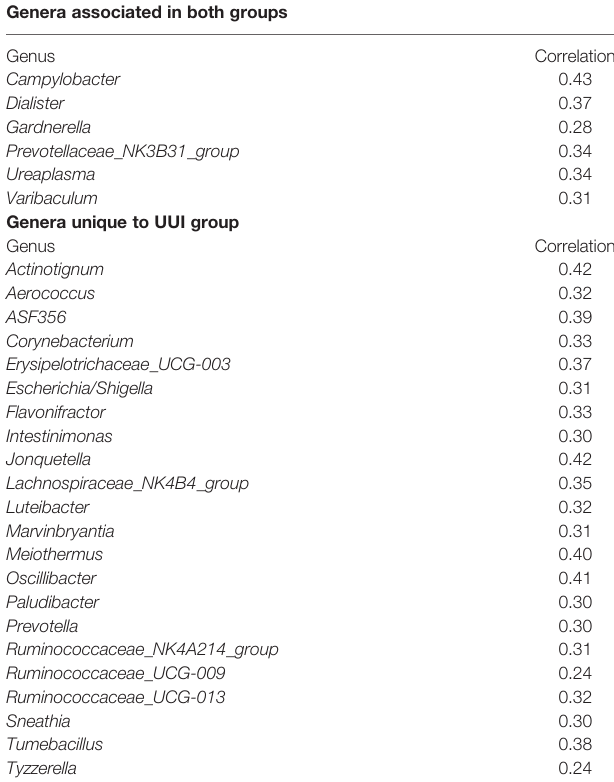
TABLE 8 | Top bacteria correlated with Lactobacillus in the urinary